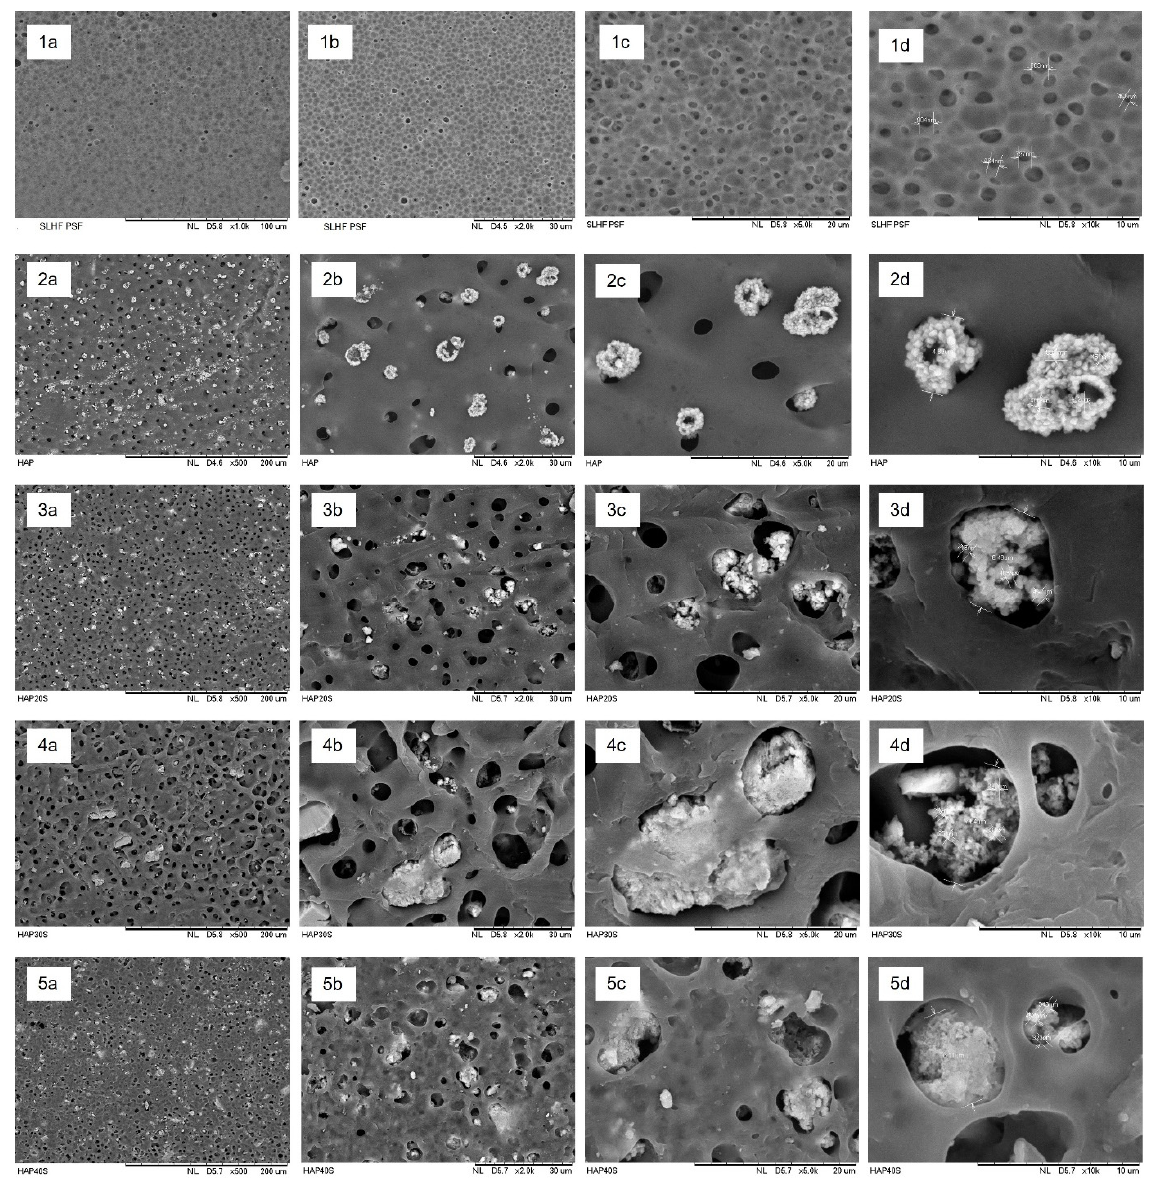
Figure 7. Outer surface SEM images of ( 1 ) M0, ( 2 ) M10, ( 3 ) M20, ( 4 ) M30, and ( 5 ) M40 at ( a ) 500×, ( b ) 2000×, ( c ) 5000× and ( d ) 10,000× magnification.